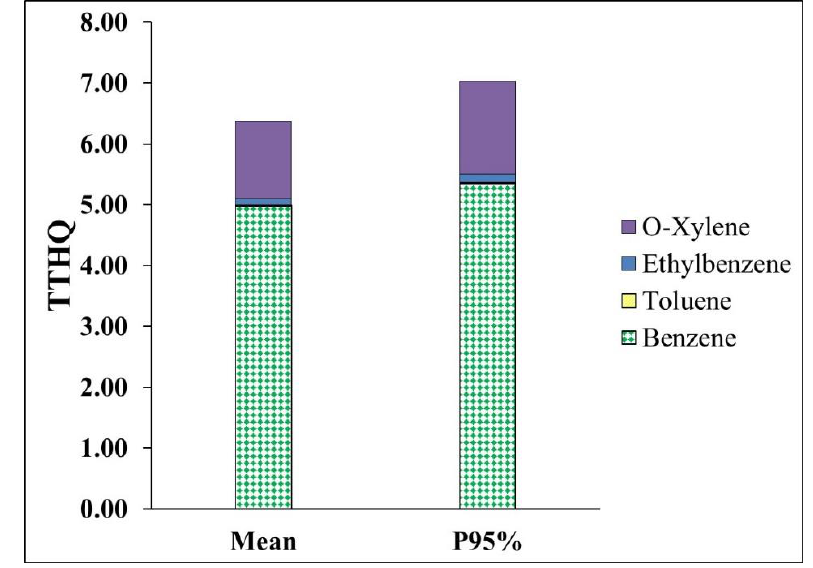
Figure 4. TTHQ of BTEX in ambient air due to inhalation exposed population.